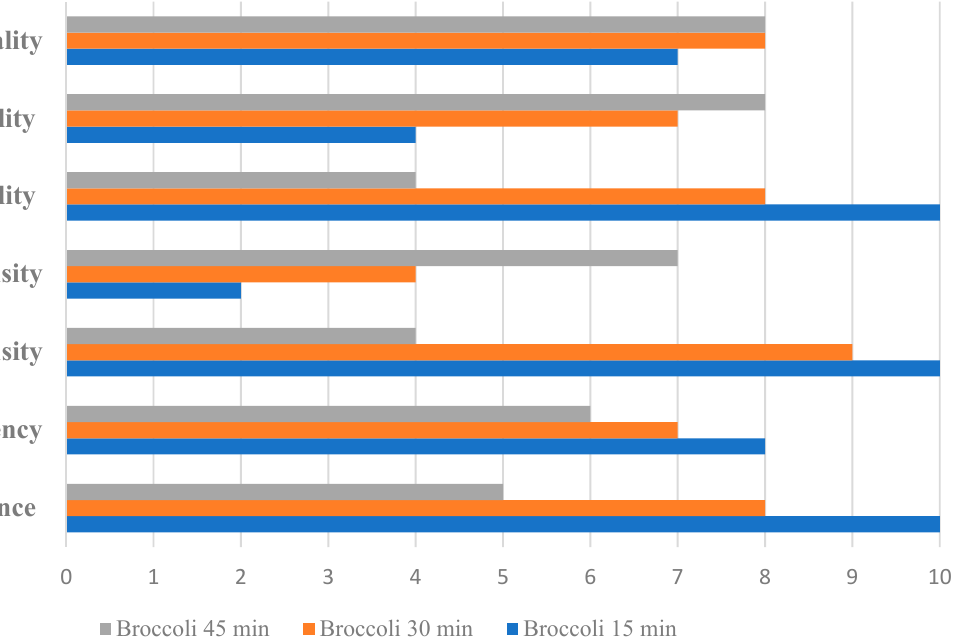
Figure 1. Results of sensory evaluation of sous-vide processed broccoli.